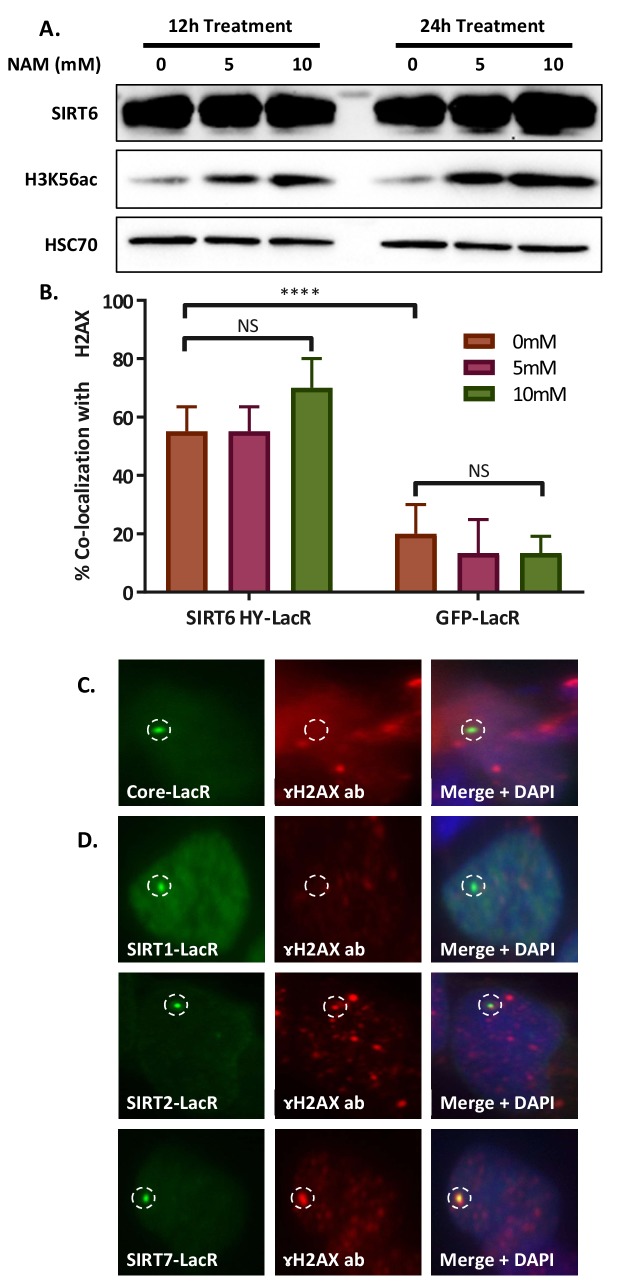
SIRT6 can initiatetheDNA damage response.(A) Western blot of nuclear protein fraction of LacO containing U2OS cells after 12 or 24 hr treatment with 0, 5 or 10 mM nicotinamide (NAM) added to their media. (B) Co-localization percentage with γH2AX of SIRT6 HY-LacR-GFP and GFP-LacR after 24 hr of treatment with NAM at three concentrations (*, p<0.05; **, p<0.005; ***, p<0.0005). (C) Immunofluorescence (IF) of co-localization of Core-LacR-GFP (n = 66, p>0.05). Experiment quantification appears in Figure 5C. (D) IF of co-localization of SIRT1-LacR-GFP (n = 44, p>0.05), SIRT2-LacR-GFP (n = 67, p<0.005) and SIRT7-LacR-GFP (n = 68, p<0.005). Experiment quantification appears in Figure 5D.